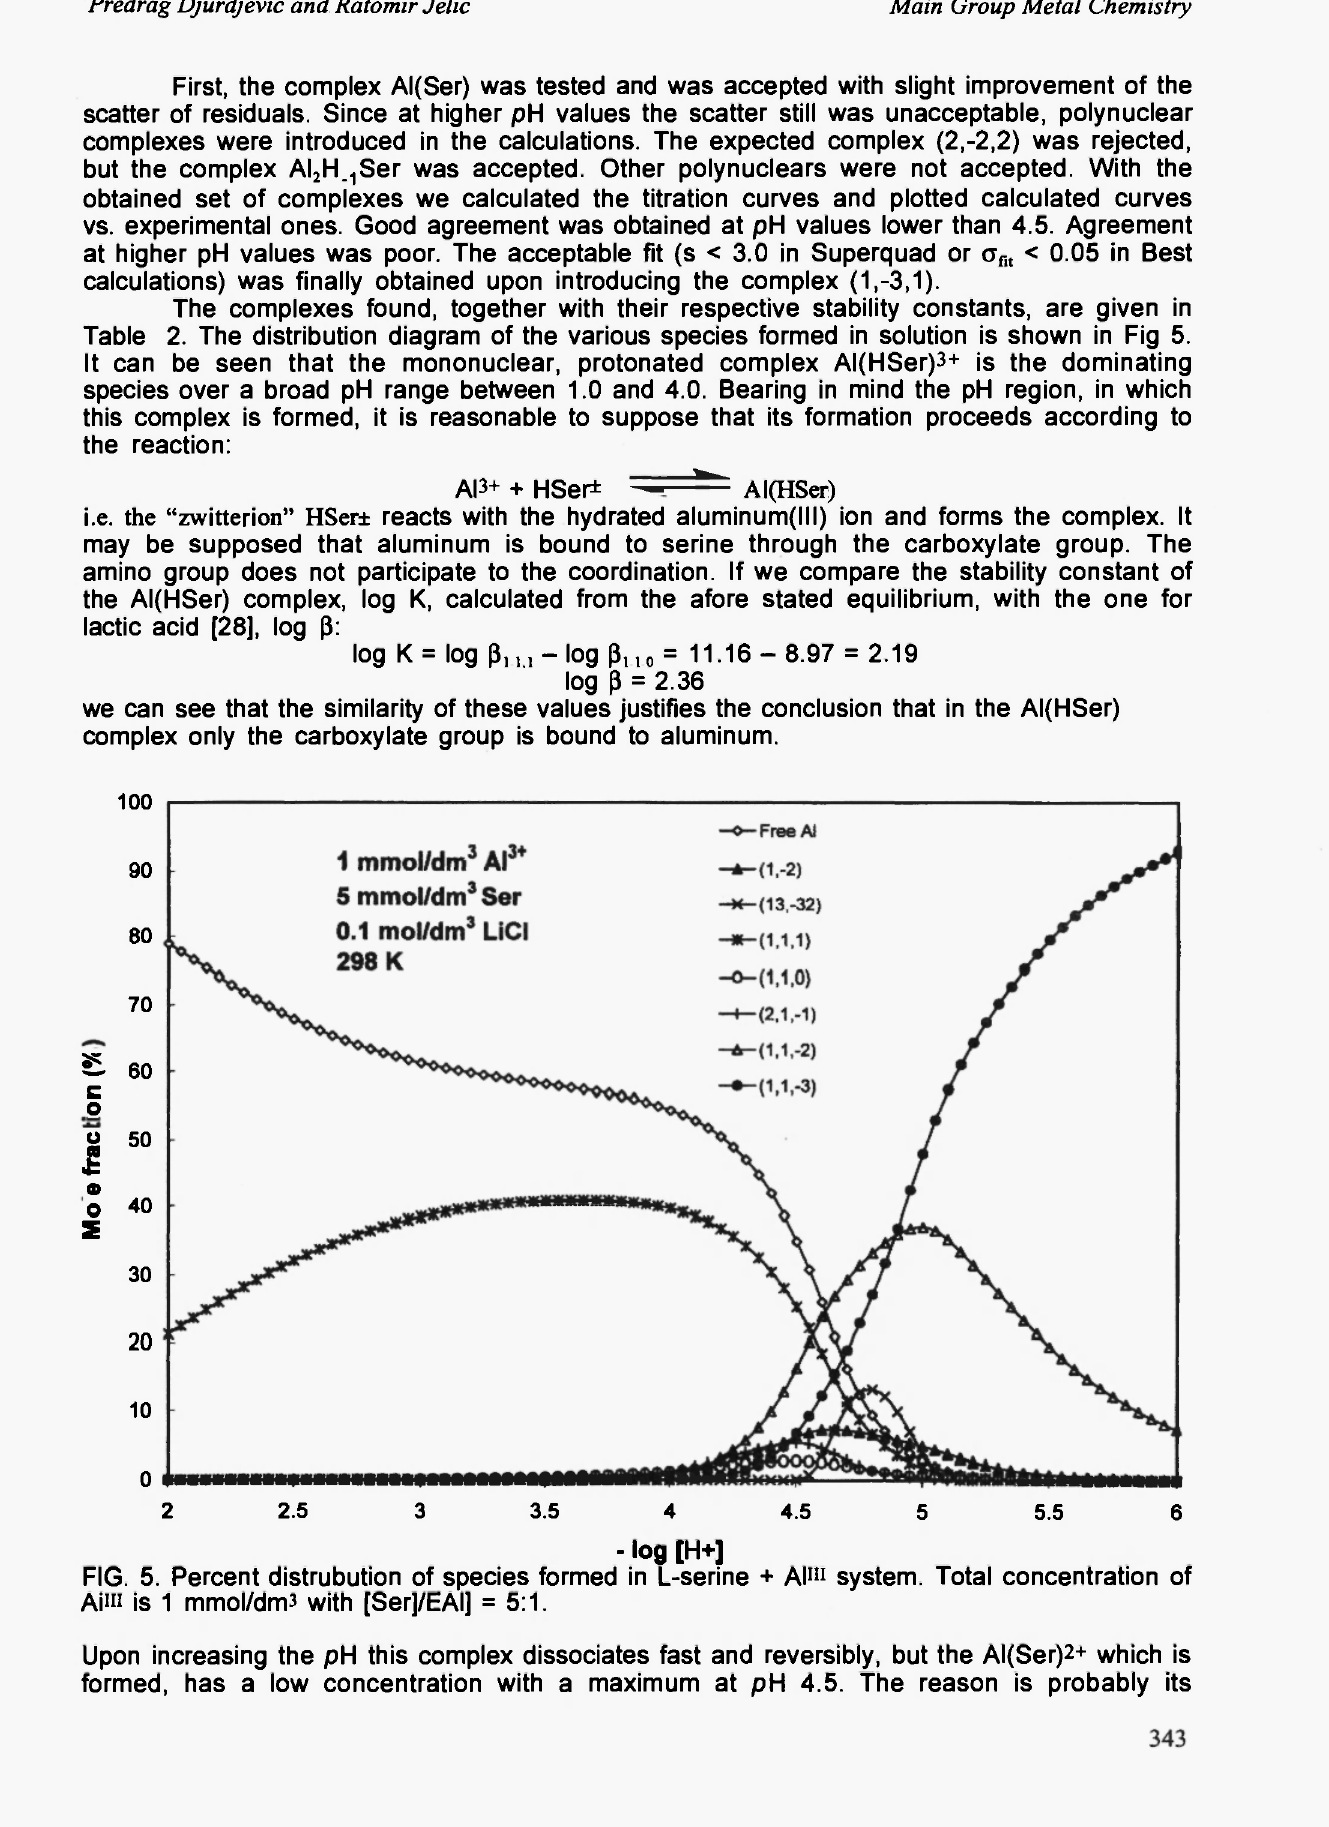
FIG. 5. Percent distrubution of species formed in L-serine + Al« 1 system. Total concentration of Aim is 1 mmol/dm* with [Ser]/EAI] =